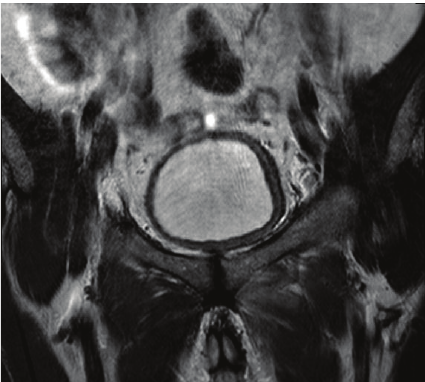
Figure 3: Pelvic MRI two months after completion of antibiotic therapy reveals no inflammatory